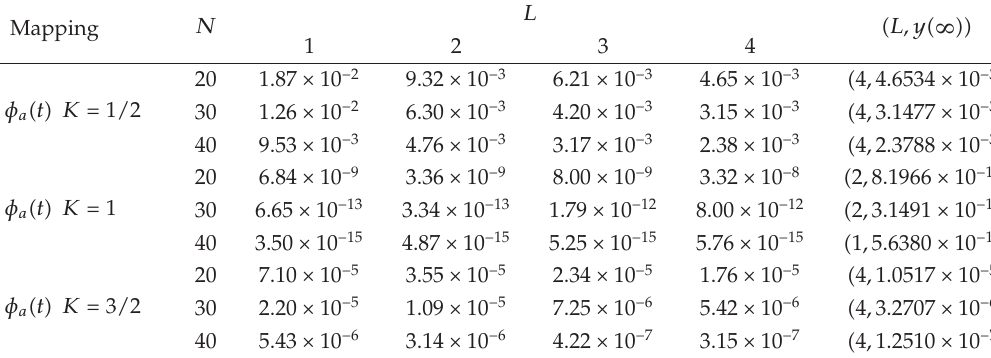
Table 6: Maximum absolute errors and approximations of y (cid:4) ∞ (cid:3) for Example 4.4.